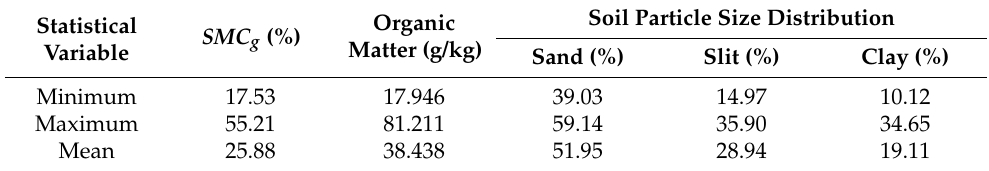
Table 1. Descriptive statistics of soil